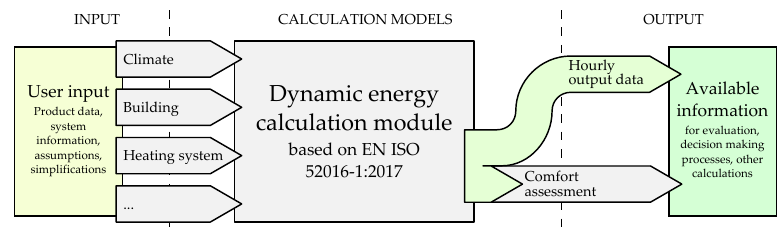
Figure 1. Modular calculation